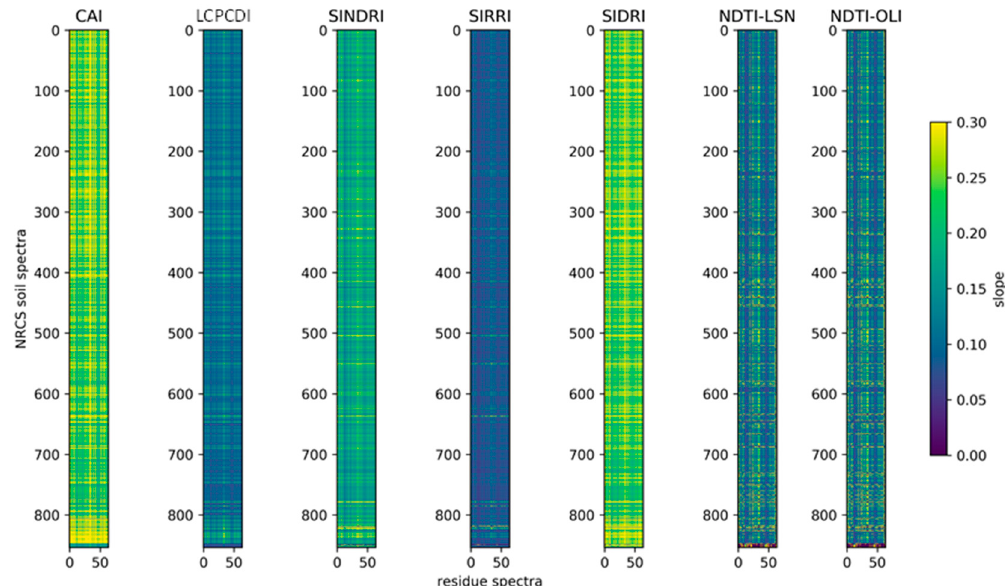
Figure 11. Slope of six select SWIR NPV indices. Ideal performance shown by color similarly (slope similarity) across different simulated soil-residue spectra combinations for each index. Note that indices cannot be directly compared to one another because differences in index scaling impacts slope. The x -axis denotes the range of 69 crop residue spectra (corn, soybean, and wheat), while the y -axis denotes the range of 854 soil spectra collected from a broad variety of soils.